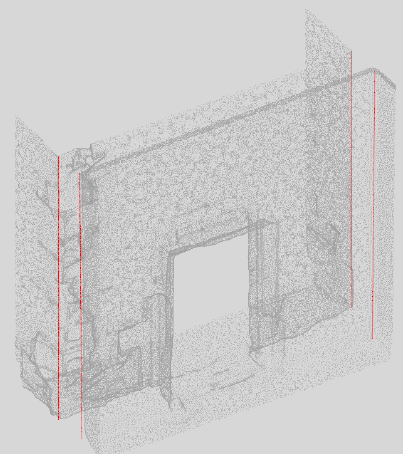
Figure17: Depiction of the vertical edges extracted against the point cloud